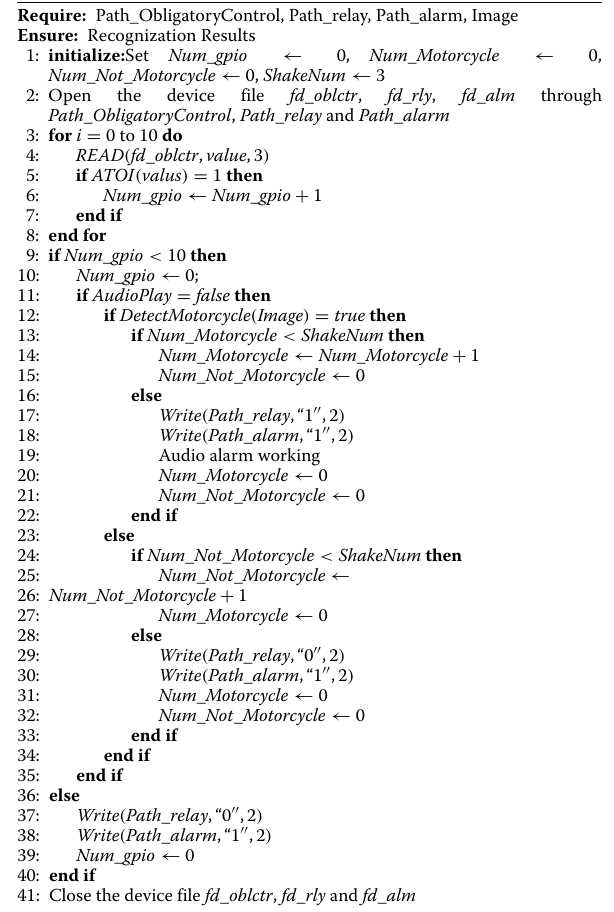
Algorithm 1 Detection and System